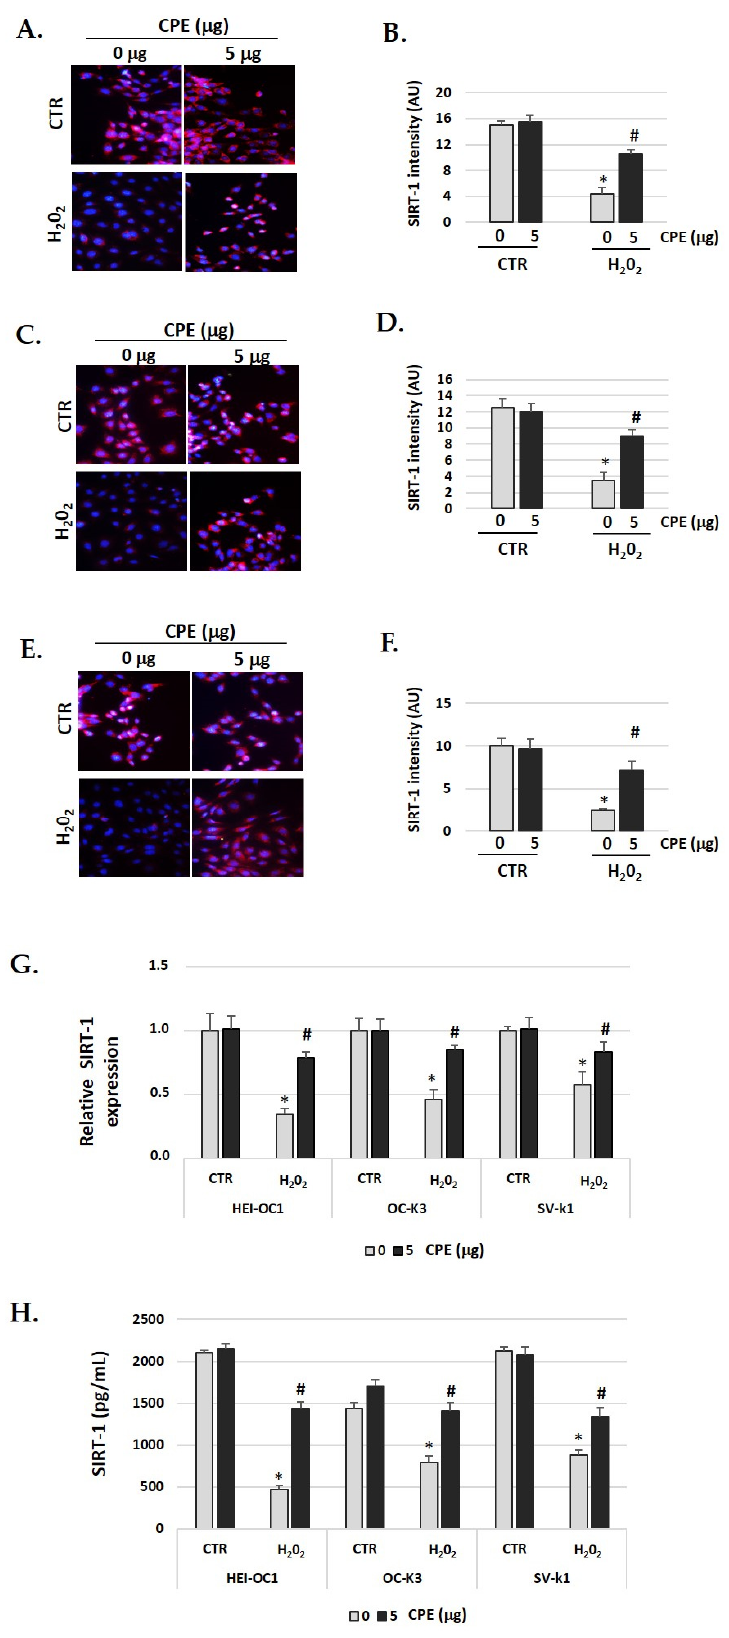
Figure 4. Cocoa increase expression of SIRT-1 in senescence cells. Illustrative fluorescence images of immunostaining of SIRT-1 in ( A ) HEI-OC1; ( C ) OC-k3, and ( E ) SV-k1 cells post-treatments.